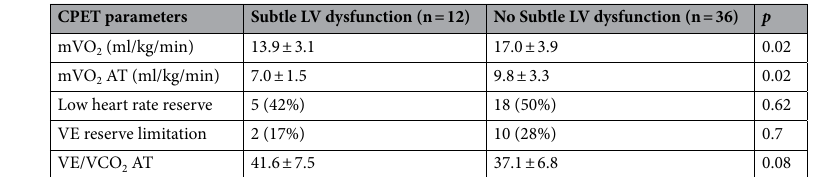
Table 3. Cardiopulmonary exercise test (CPET) results between the subtle left ventricular (LV) dysfunction group and the non-subtle LV dysfunction group. VE reserve limitation: VE > 0.85 maximum VE. Low heart rate reserve: 220 – age – Heart rate > 15. Data are expressed as mean ± SD. AT, at anaerobic threshold; mVO 2, maximum oxygen uptake; VE, minute ventilation.